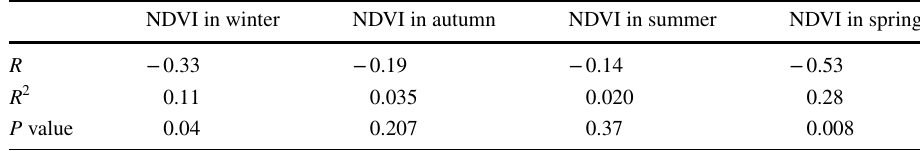
Table 3 Correlation between NDVI and methane in different months in 2018